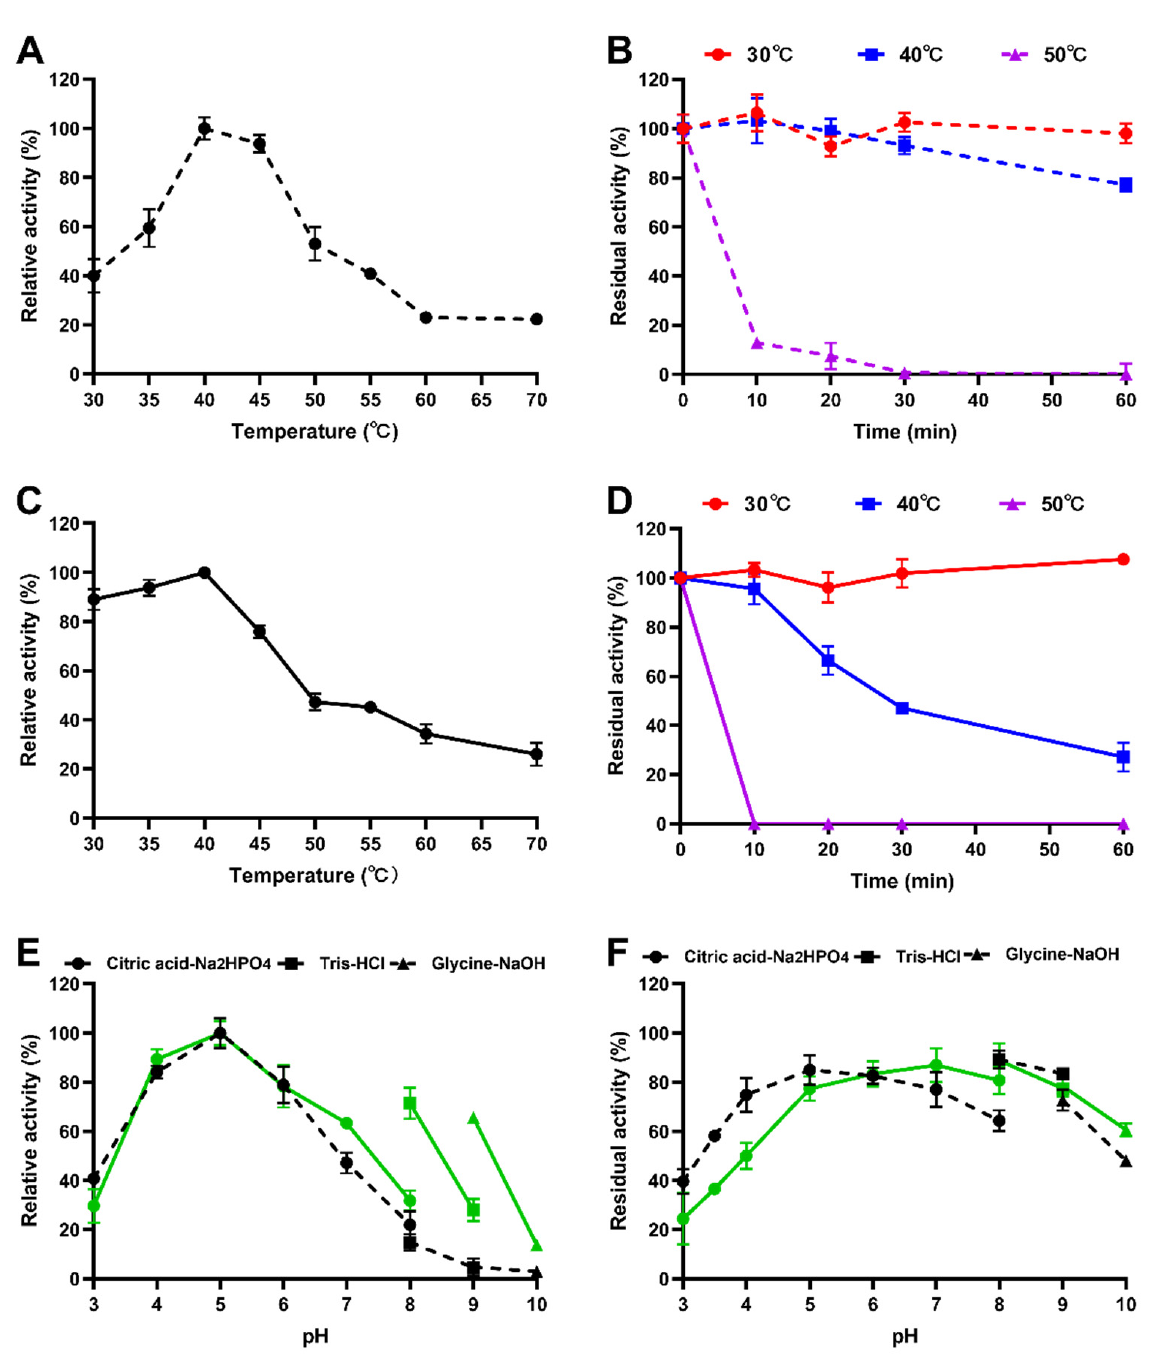
Figure 3. Characterization of recombinant polygalacturonases. ( A ) Optimum temperature of IDSPGA28-4; ( B ) thermostability of IDSPGA28-4; ( C ) optimum temperature of IDSPGA28-16; ( D ) Thermostability of IDSPGA28-16; ( E ) optimum pH of IDSPGA28-4 (dotted line) and IDSPGA28-16 (solid line); ( F ) pH stability of IDSPGA28-4 (dotted line) and IDSPGA28-16 (solid line). Data represent the mean ± SD ( n = 4).